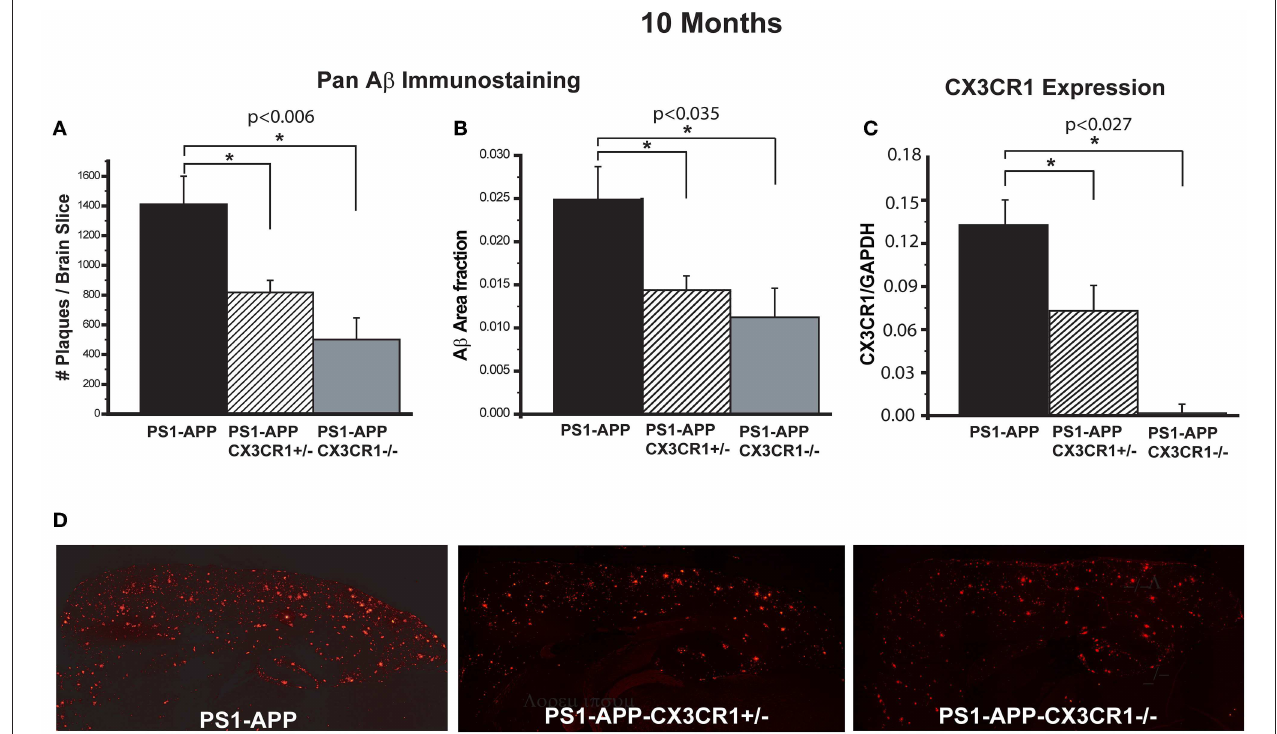
FIGURE 1 | CX3CR1 deficiency results in reduced A β deposits and levels of A β in 10-month old PS1-APP-CX3CR1-deficient genotypes. (A–C) Fixed brain sections from 10-month old PS1-APP, PS1-APP-CX3CR1 + / − , and PS1-APP-CX3CR1 − / − mice were stained using polyclonal pan-A β antibody. The number of A β deposits (A) and A β -deposit area fraction (B) were determined using three sections per mouse (Values represent group mean ± SEM). (C) Quantitative PCR measurements of CX3CR1 RNA in 10-month old PS1-APP, PS1-APP-CX3CR1 + / − , and PS1-APP-CX3CR1 − / − microglia show a gene dosage effect. (D) Representative fluorescent micrographs of plaques (red) in PS1-APP, PS1-APP-CX3CR1 + / − , and PS1-APP-CX3CR1 − / − mice. For all measurements in this figure, n = 6 for PS1-APP, n = 7 for PS1-APP-CX3CR1 + / − , and n = 3 for PS1-APP-CX3CR1 − / − . * represent statistically